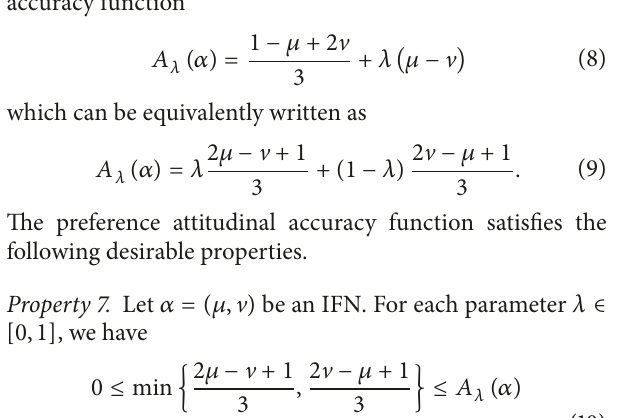
Figure 1: The feasible domain with respect to 𝛼 .